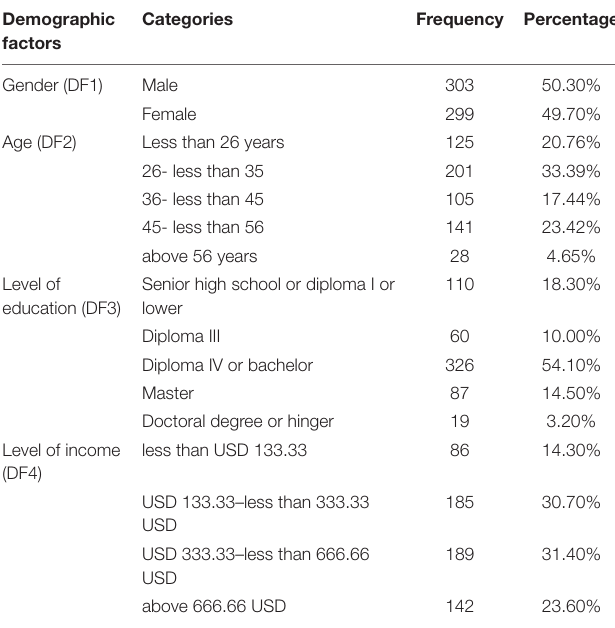
TABLE 2 | Demographic profile of the participant.